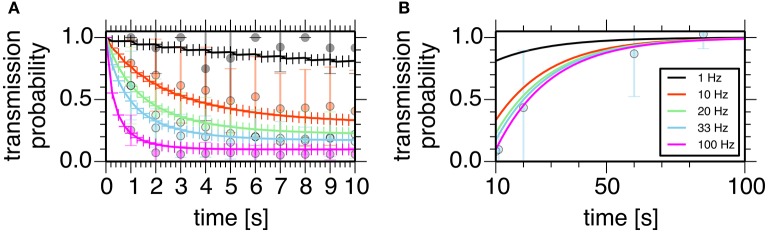
Properties of the short-term depression model at a GPe-STN synapse. Plots show simulated transmission probability of a single GPe axon stimulated at 1, 10, 20, 33, and 100 Hz for 10 s. (A) Depression during stimulation. (B) Recovery from the depression. Crosses represent simulation results, and circles with error bars represent means and standard deviations of experimental data (Atherton et al., 2013).